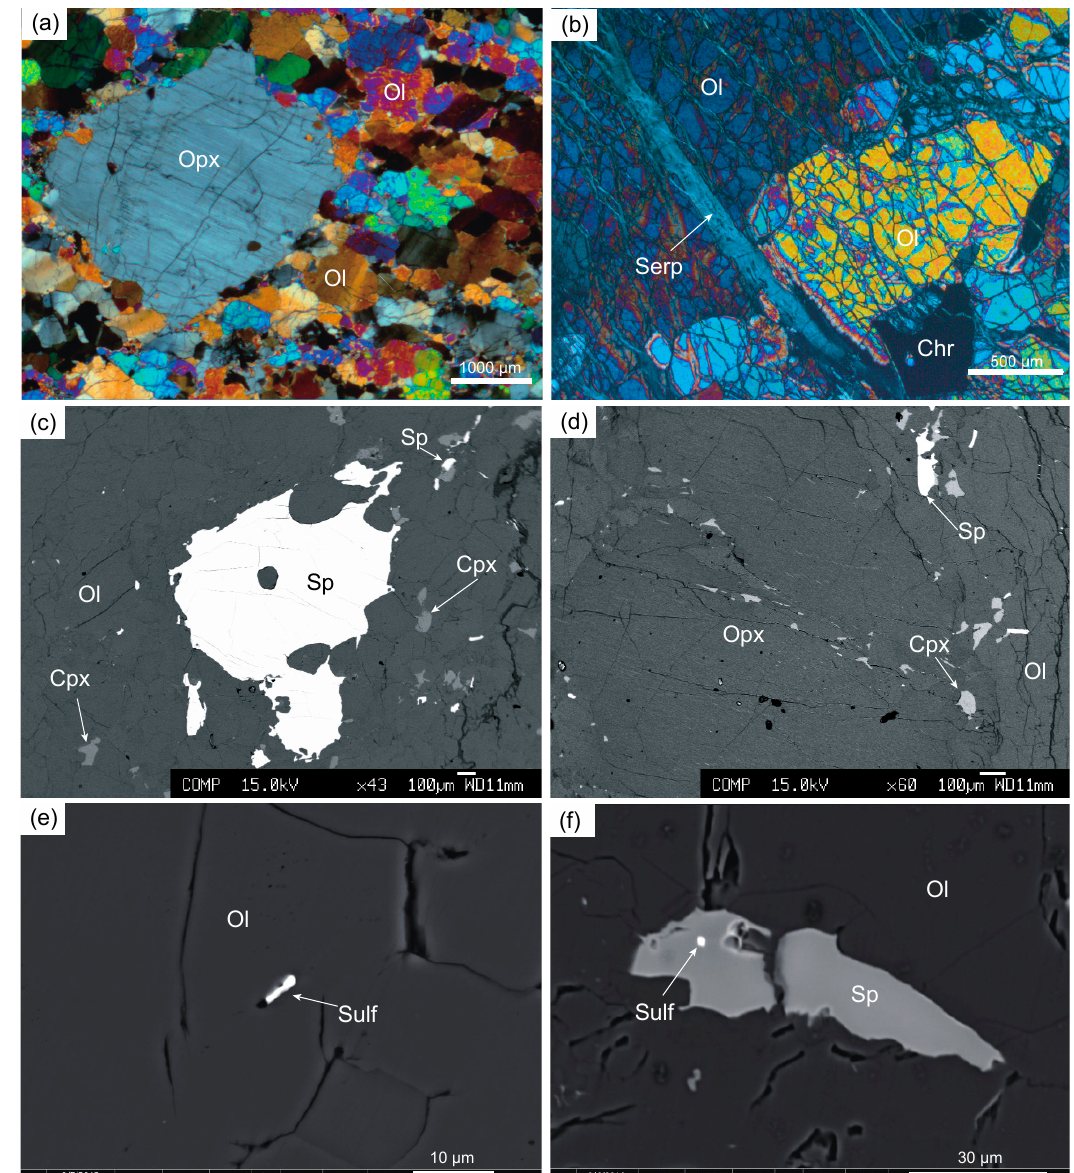
Figure 2. Microstructure of the Me Maoya harzburgites. ( a ) Harzburgite with a porphyroclastic texture, orthopyroxene porphyroclasts, and olivine porphyroclasts are surrounded by olivine neoblasts; note kink bands in some olivine (15NC21); ( b ) olivine partially altered to serpentine along cracks (15NC12); ( c ) large spinel grain with a lobate shape in a olivine matrix (15NC25); ( d ) orthopyroxene with clinopyroxene exsolution lamellae, small spinel, and clinopyroxene, disseminated in the olivine matrix (15NC23); ( e ) tiny sulfide enclosed within olivine (15NC22); ( f ) rounded sulfide bleb enclosed in spinel (15NC26). Ol: Olivine; Opx: Orthopyroxene; Cpx: Clinopyroxene; Sp: Spinel; Chr: Chromite; Sulf: Sulfide.